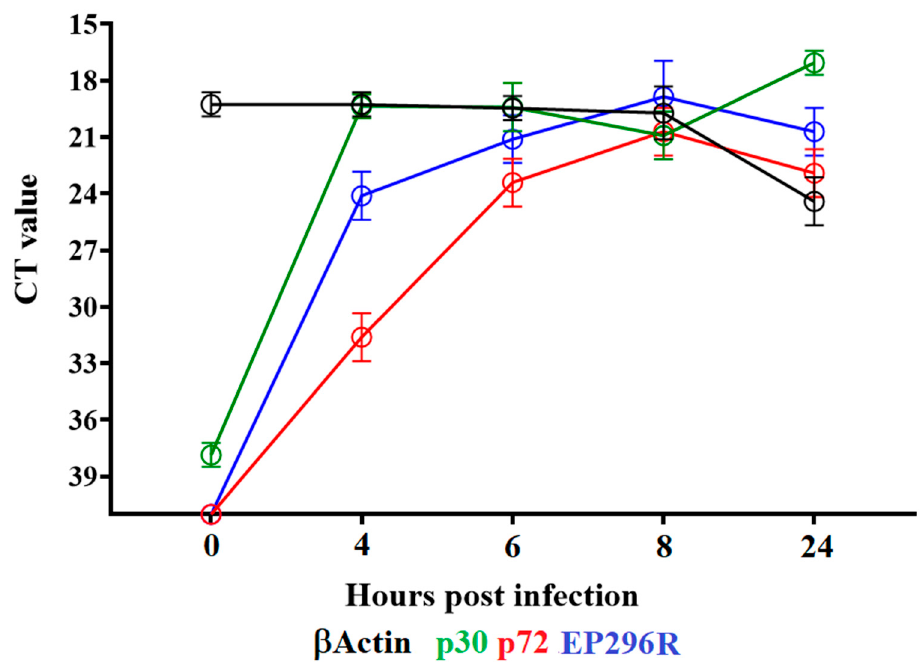
Figure 3. Expression profile of EP296R gene of ASFV during in vitro infection of porcine macrophages. Reverse transcription followed by qPCR was used to evaluate the expression profile of the EP296R gene during in vitro infection at different time points, up to 24 h. As a reference for this analysis, we used qPCRs to specifically detect the expression of genes encoding ASFV proteins p30 (early expression) and p72 (late expression). Additionally, the β -actin gene was used as a control to evaluate the quality and levels of RNA during the infection at different timepoints.